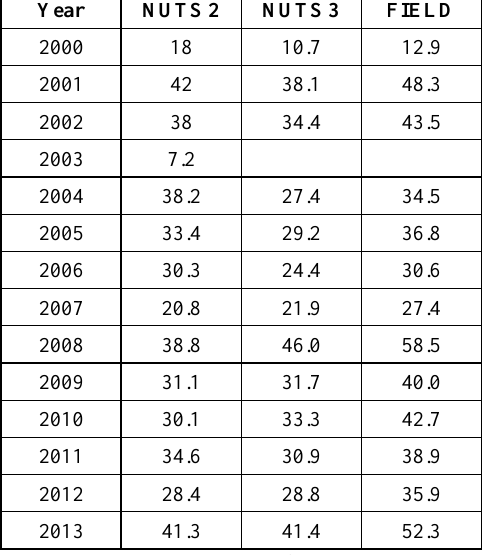
Table 1. Crop yield statistics and field level crop yield